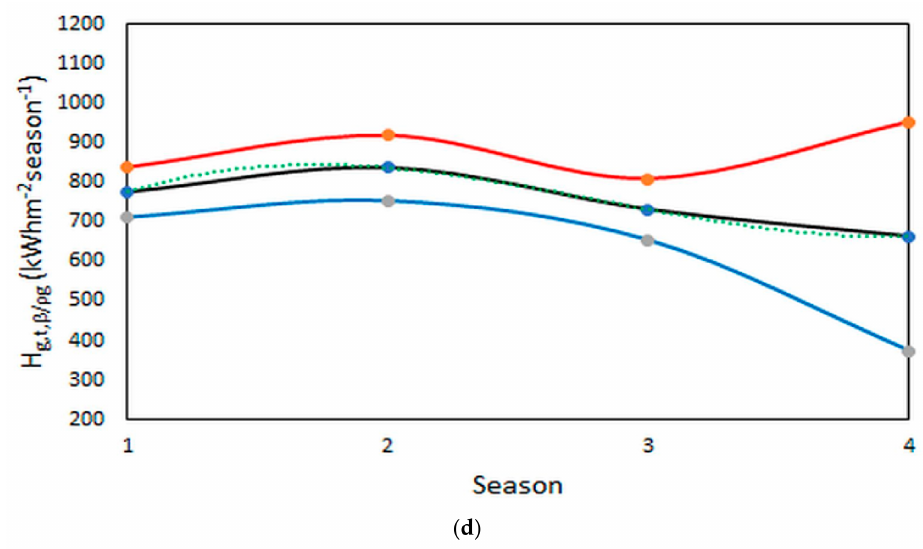
Figure 7. Seasonal variation of ( a ) H g,t,40/ ρ g in SEZ-A, ( b ) H g,t,45/ ρ g in SEZ-B, ( c ) H g,t,50/ ρ g in SEZ-C, and ( d ) H g,t, β / ρ g in all SEZs. The black lines represent the seasonal mean. The red lines refer to the mean + 1 σ curves, and the blue ones to the mean—1 σ curves, under all-sky conditions and averaged over the period 2005–2016. The green dotted lines refer to the best-fit curves to the mean ones. The numbers 1–4 in the x -axis refer to the seasons in the sequence spring to